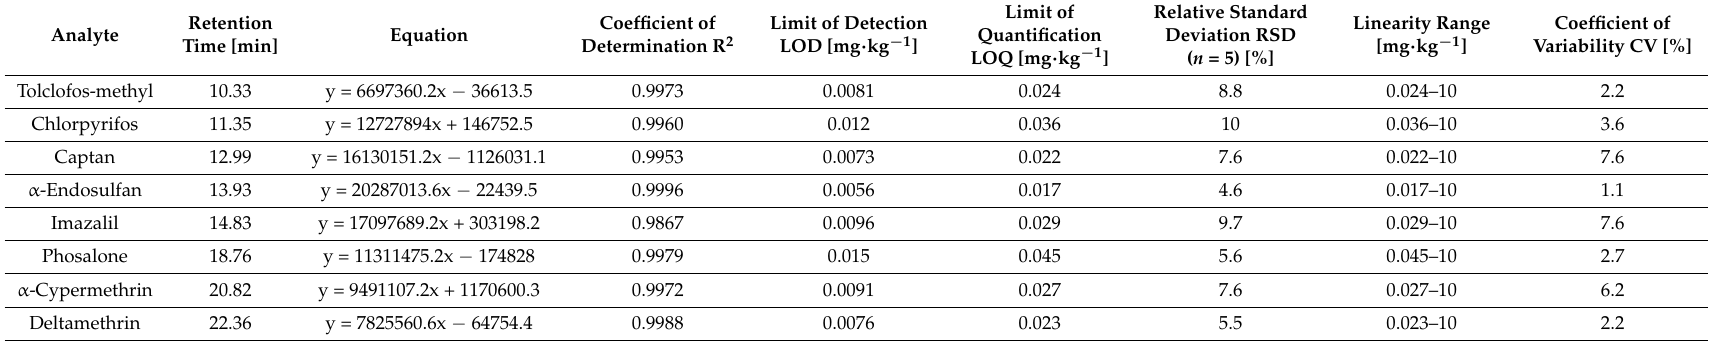
Table 1. Basic validation data for selected pesticides obtained by using QuEChERS coupled with